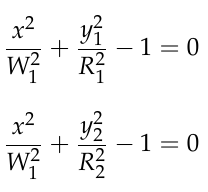
Figure 4. The surface current distribution of Ant-1. ( a ) 0.39 GHz. ( b ) 0.97 GHz. To achieve a broader operating bandwidth, two rectangle slots are replaced with ta- pered slots by adopting flaring ground. As depicted in Figure 2b, the black dashed-dotted line corresponds to the outline of the flaring ground that satisfies the elliptical equation: